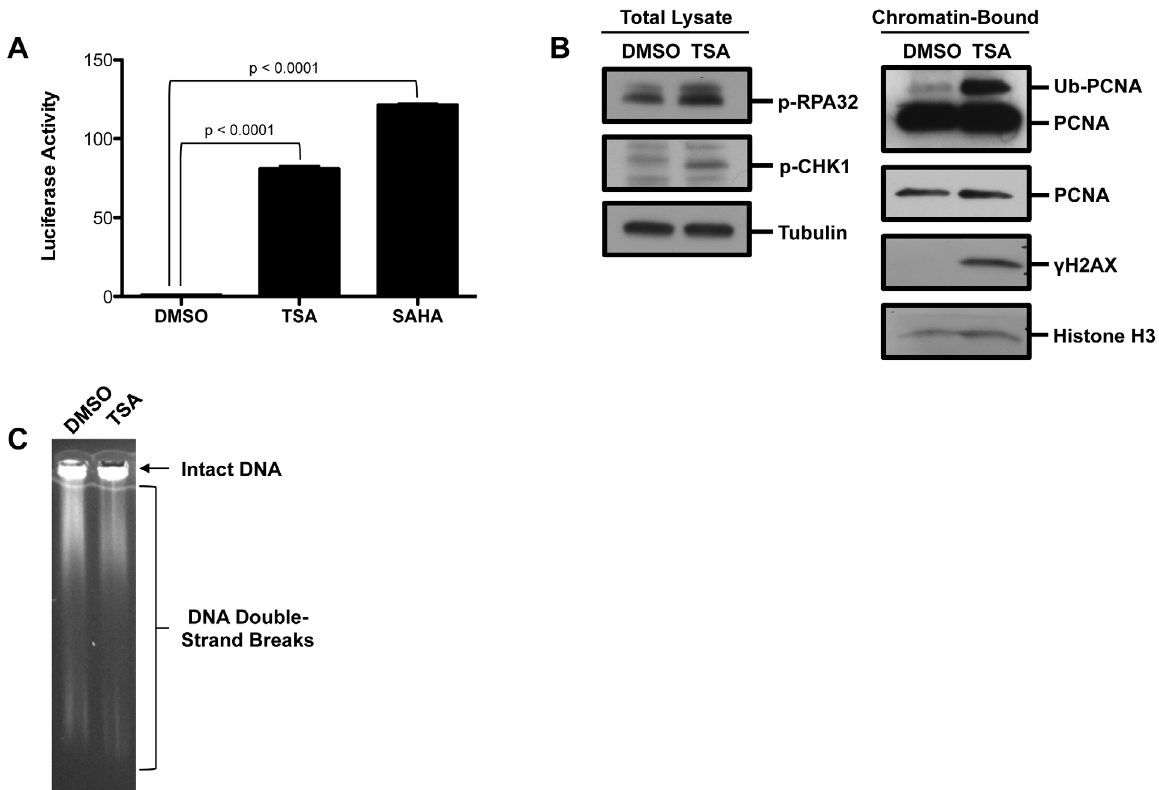
Figure 1. Trichostatin A induces DNA damage. (A) HEK293T ELG1-LUC cells were treated with 0.75 m M TSA or 50 m M SAHA for 48 hr. LUC activity was measured using One-Glo. The graph represents average LUC activity 6 SD. Significance was calculated using a two-tailed t-test. (B) HEK293T cells were treated with 50 m M TSA for 24 hr. Using the indicated antibodies proteins levels were visualized by Western blot analysis from either the chromatin-bound fraction or total cell lysate. (C) HEK293T cells were treated with 100 uM TSA for 24 hours and then Pulsed-field gel electrophoresis was performed.